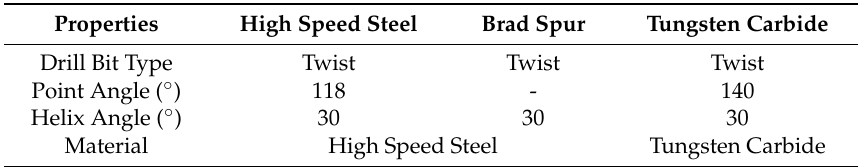
Table 2. The properties of drill